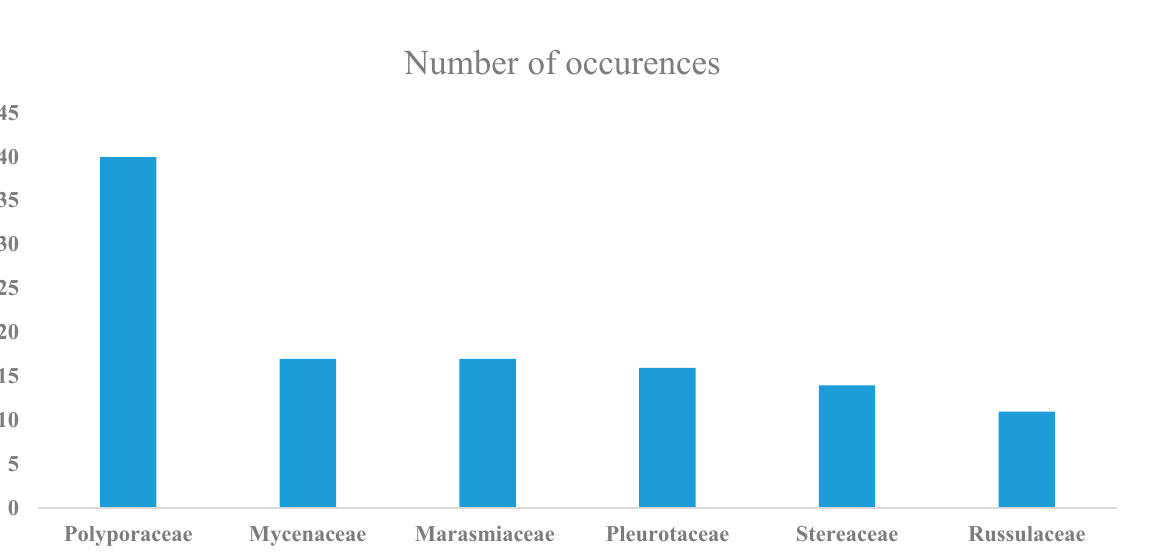
Figure 1. Common families of wood-decay fungi recorded in the present study. The approximate volume (m 3 ) was calculated for each woody substrate based on the measurements taken for length (m) and diameter (m), and the values obtained on the percentage of bark present were assigned to categories (Tables 1 and 2). For example, the volume averages (based on > 10 occurrences) of Merulius incarnatus, Stereum ostrea , and Trametes elegans were 0.44, 0.36, and 0.25 m 3 , respectively. In contrast, Sarcoscypha occidentalis and Exidia recisa were recorded with the lowest volume averages, 6 and 22 cm 3 , respectively. Both of these species were present at a relatively early stage (percent bark <75%) of decomposition (Table 3). Table 1. Distribution of fungi in relation to the volume of the woody substrate. Number of Records